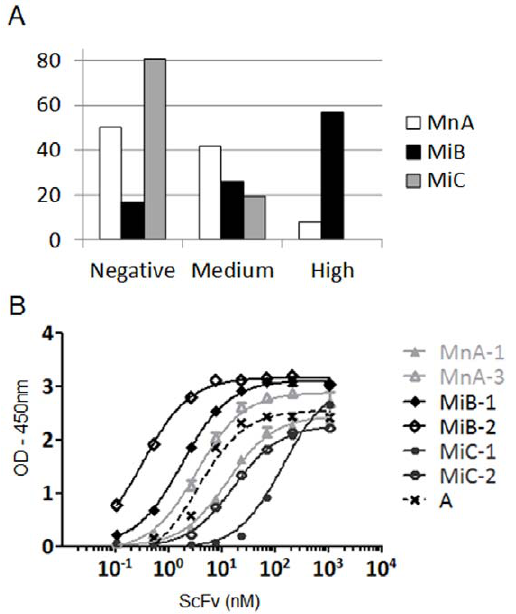
Figure 3. Screening of selections outputs from biased and naive murine libraries. (A) The supernatants of random clones from the selection round 3 against hIFN c were tested independently in scFv ELISA against the same antigen (88 clones tested for each library). Clones were then ranked according to their level of absorbance at 450 nm. Were defined ‘‘high’’, clones with absorbance values above 70% of the signal of a positive control scFv (absorbance , 2.1), ‘‘medium’’, clones between 10% and 70% (absorbance 0.3 and 2.1) and ‘‘negative’’, clones below 10%. Histograms show the percentage of clones relative to their corresponding level of absorbance. (B) The two most frequent clones according to NGS were purified as scFv and tested in parallel in a dose response ELISA against hIFN c (n=2). Sequences from these clones are given in Table 2. The graph shows the level of absorbance at 450 nm in function of scFv concentration in nM. A is a positive control scFv.